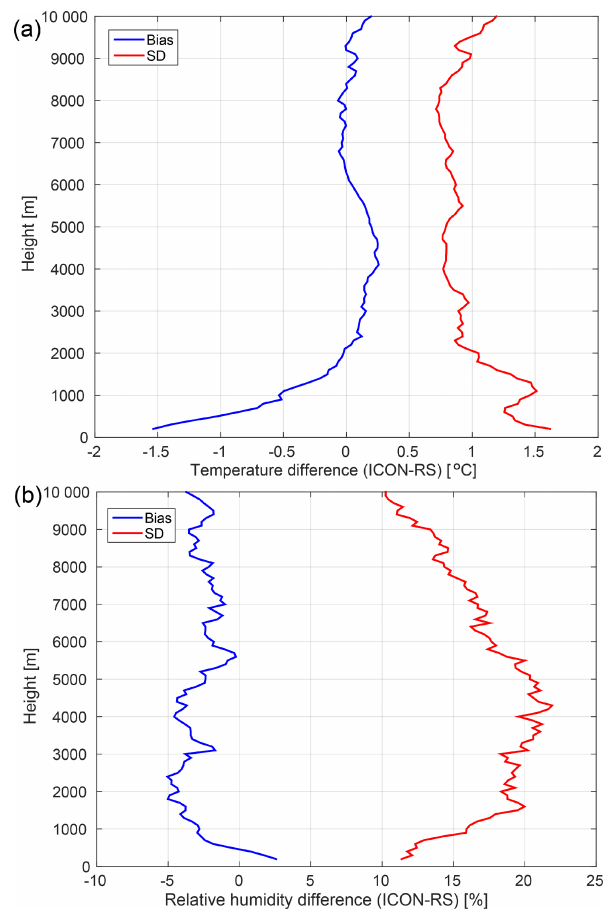
Figure 2. Difference in temperature (a) and relative humidity (b) between the ICON column output over Ny-Ålesund and radiosonde data for the period from February 2017 to July 2017. Blue and red lines show the bias and the standard deviation,